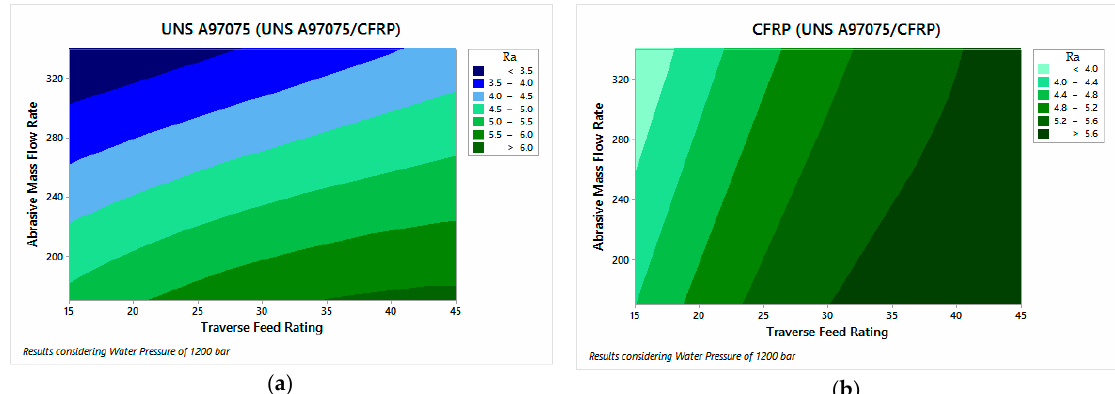
Figure 12. Roughness for UNS A97075/CFRP configuration: ( a ) UNS A97075 and ( b ) CFRP.